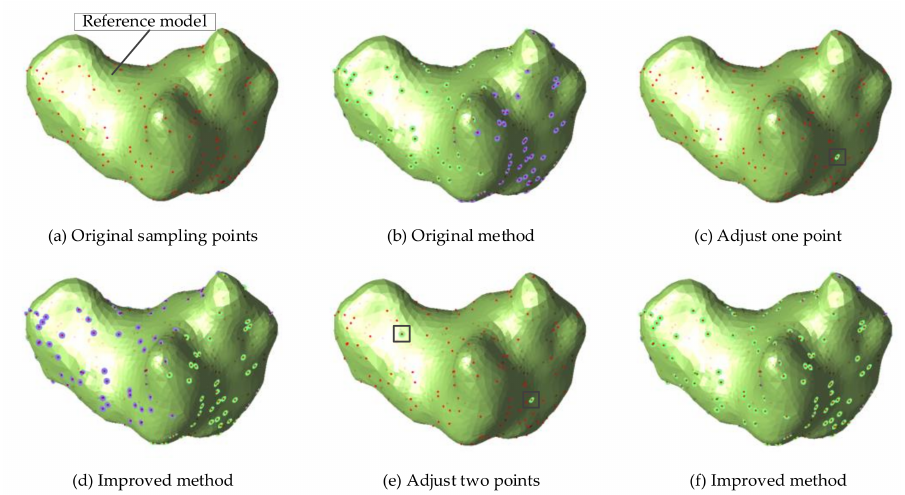
Figure 9. Normal estimation results of the second data set. ( a , b ) show the original sampling points and the normal estimation result obtained by the original method. ( c , d ) show the normal estimation result obtained after adjusting the normal of only one point. ( e , f ) show the normal estimation result obtained after adjusting the normals of two points.